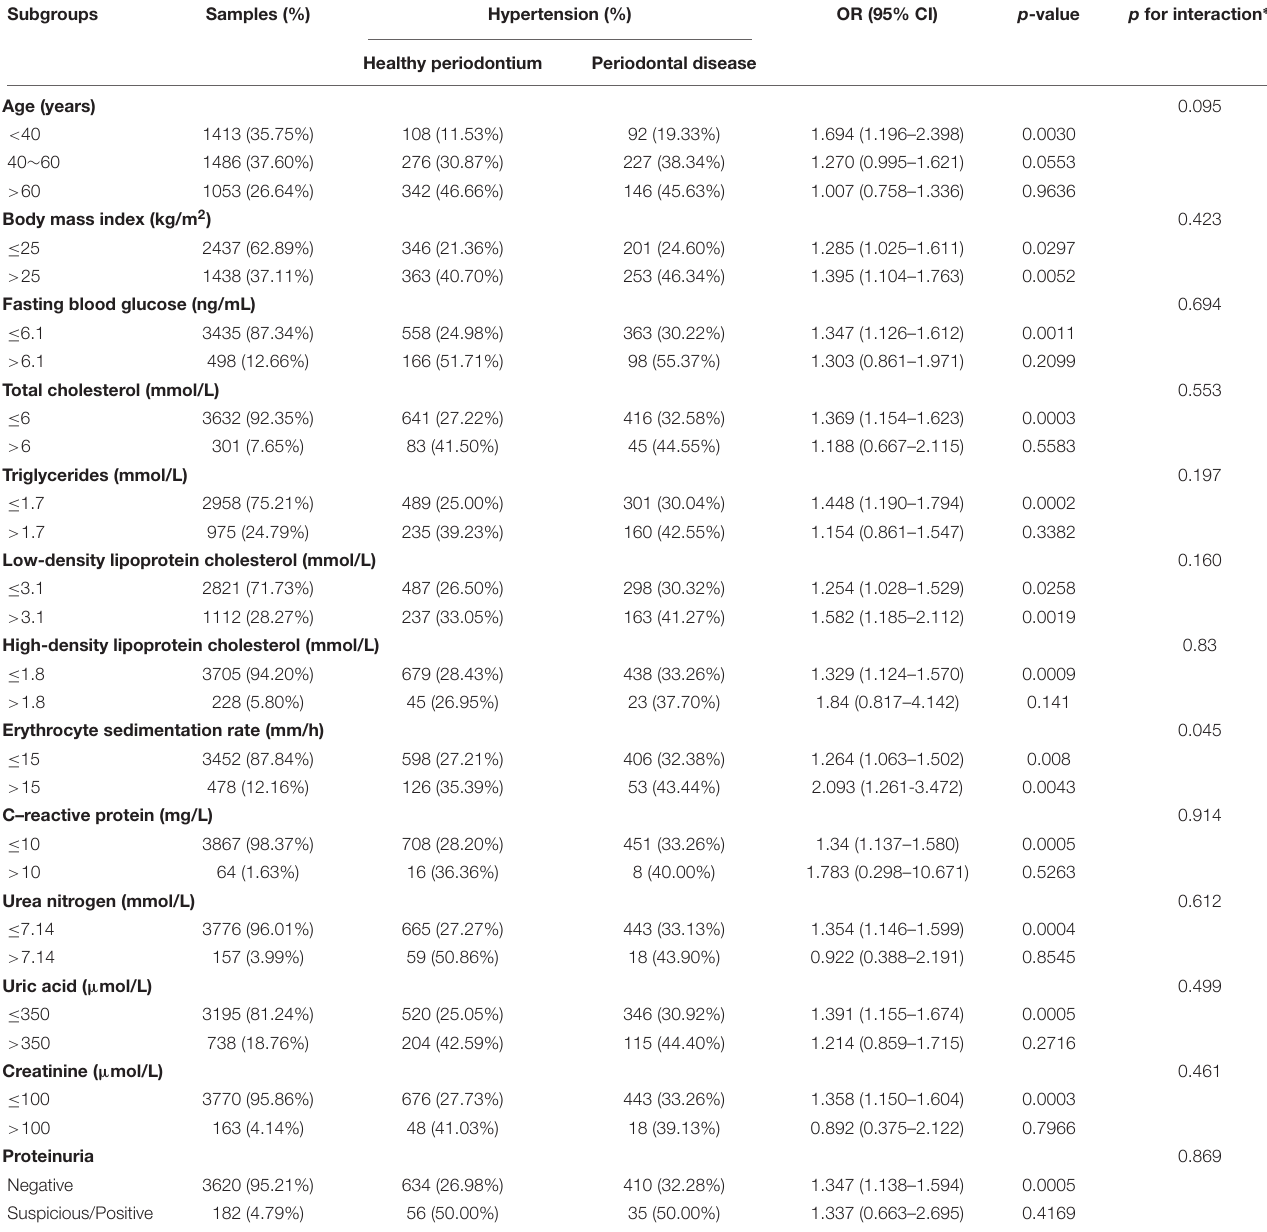
TABLE 3 | Interaction and subgroup analyses results of relationship between periodontal disease and hypertension.